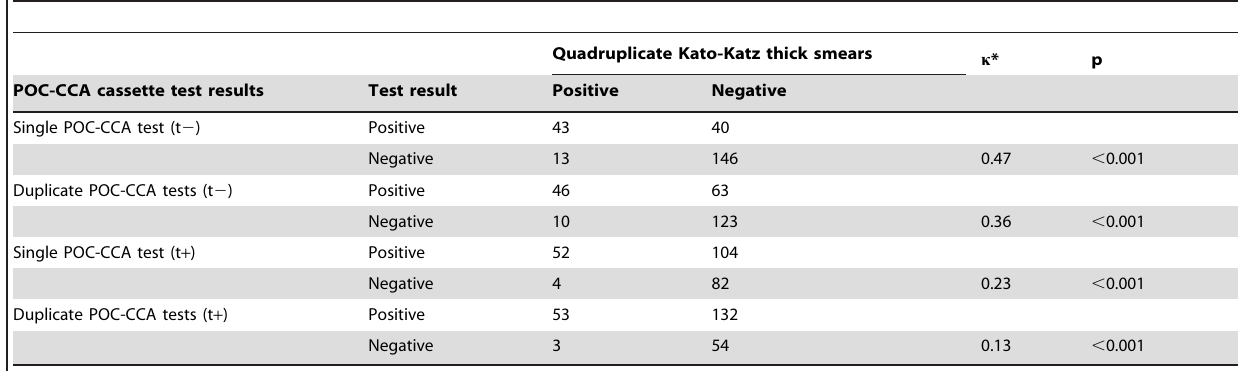
Table 3. Agreement between Kato-Katz technique and POC-CCA cassette test for the diagnosis of S. mansoni .